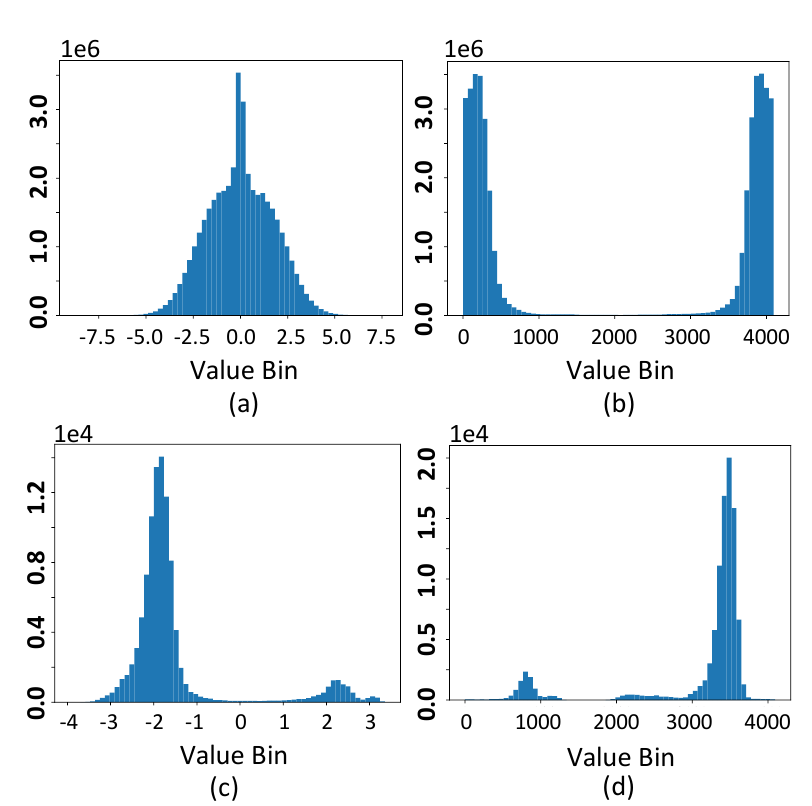
Figure 3: The histogram of feature maps before binarization for (a) third hidden layer, (c) output layer, for baseline MLP, and (b) third hidden layer, and (d) output layer, for ModuloNET MLP, using 64 bins. Activations are obtained using feed-forward run of the networks on the entire MNIST test split. Vertical axis shows the number of occurrences of activation values in the bin while horizontal axis shows the histogram